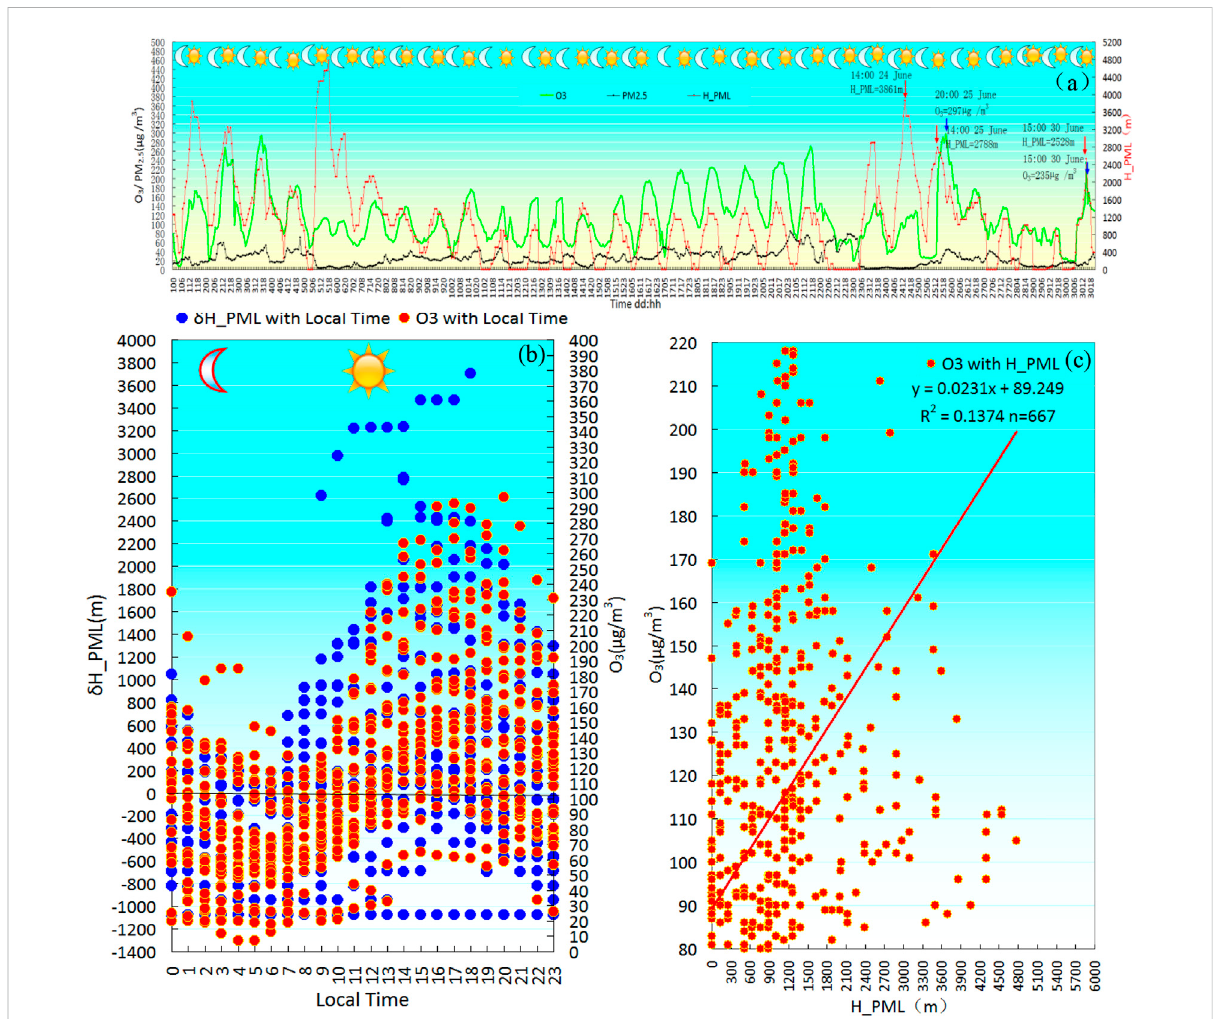
FIGURE 4 (A) Observed distribution of hour-by-hour O 3 in June 2022 in Beijing and daytime fl uctuations in the pollution boundary layer height H-PML calculated by Eq. 4, as well as hourly changes of PM 2.5 . (B) Comprehensive analysis of O 3 and δ H_PML at the local time of hourly resolution in June 2022 in Beijing, The ordinate (left) is for δ H-PML, where the δ H-PML is theanomaly labeled as theaverage value of 1000 m. (C) Correlation between the hourly O 3 and H_PML in June 2022 in